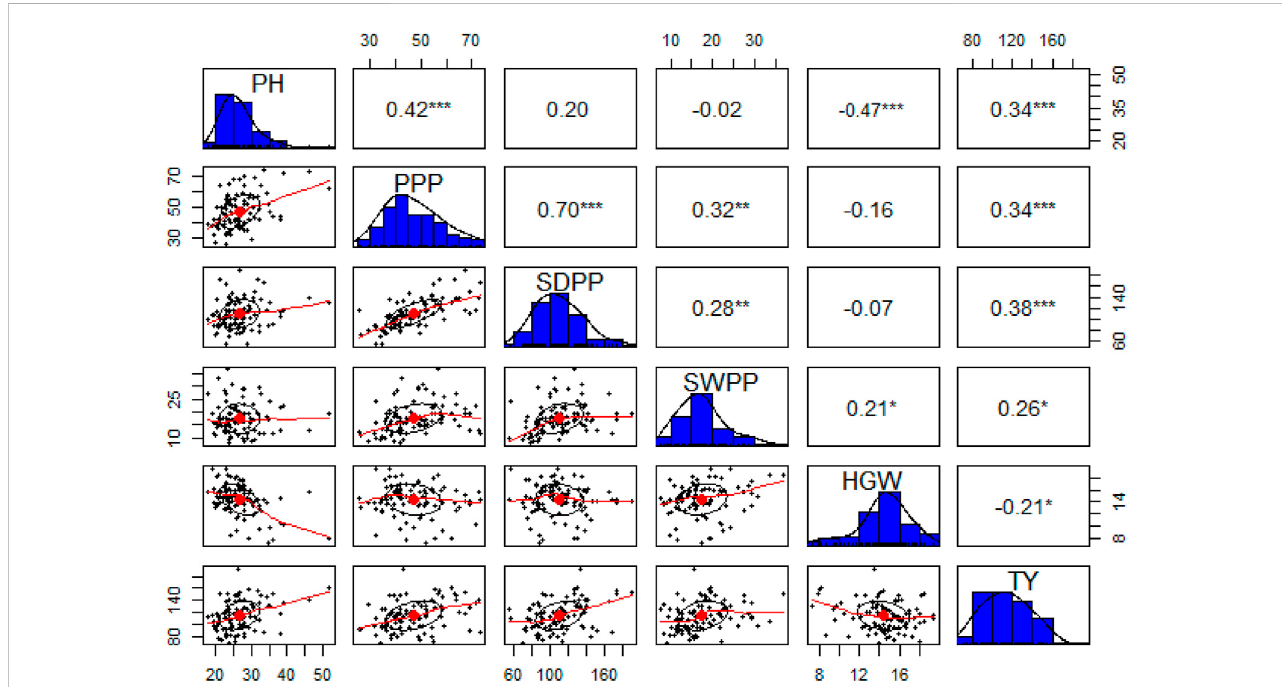
FIGURE 5 Correlation matrix (upper triangle), frequency distributions (blue bars), and bivariate scatter plots with a fi tted line at lower triangle are shown for plant height (PH), pods per plant (PPP), seeds per plant (SDPP), seed weight per plant (SWPP), hundred-grain weight (HGW), and total yield (TY).